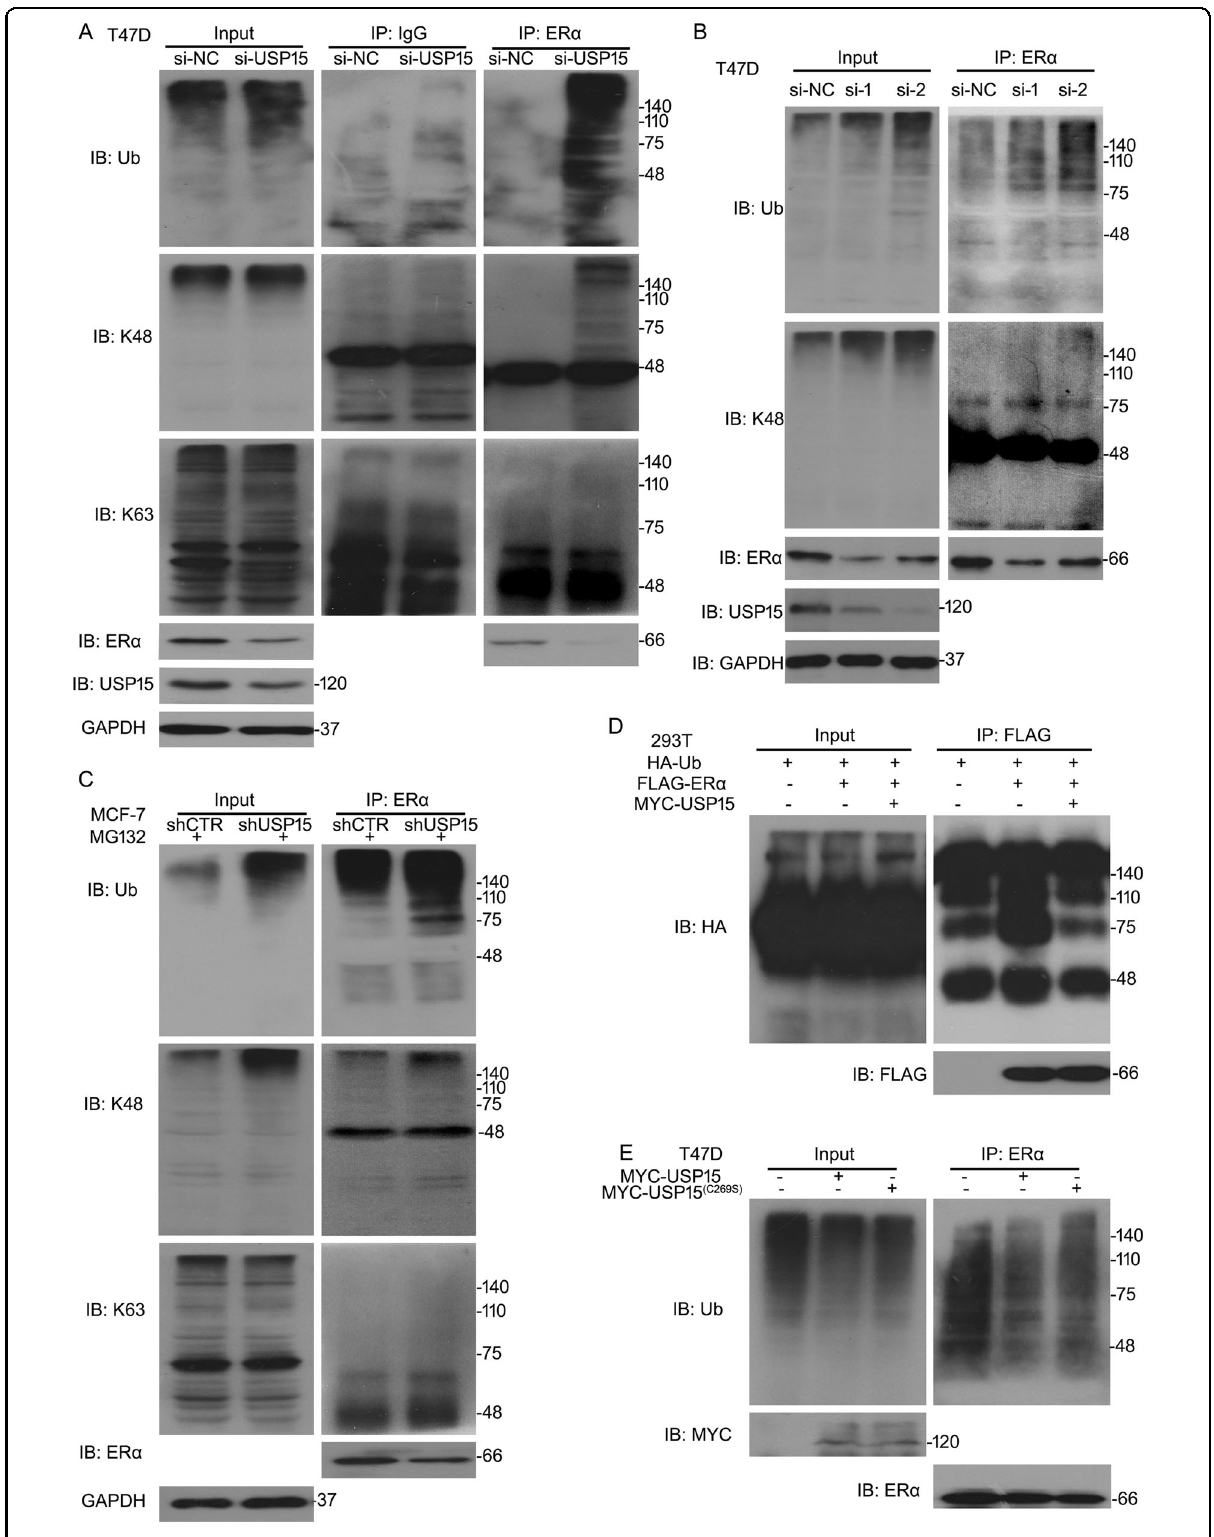
Fig. 5 USP15 promotes deubiquitination of ER α . A T47D cells were exposed to USP15 siRNA. B T47D cells were treated with USP15 siRNA-1, -2. C MCF- 7 cells were exposed to USP15 shRNA. Proteins were extracted from the above-treated cells. Immunoprecipitated with ER α beads and then immunoblotted with ubiquitin (Ub), K48, ER α , K63. D Cells were treated with MYC-USP15, HA-Ub, and FLAG-ER α . Immunoprecipitated with FLAG and then immunoblotted with HA. E T47D were transfected with MYC-tagged USP15 mutant (C269S), USP15 (WT). Immunoprecipitated with ER α and then immunoblotted with